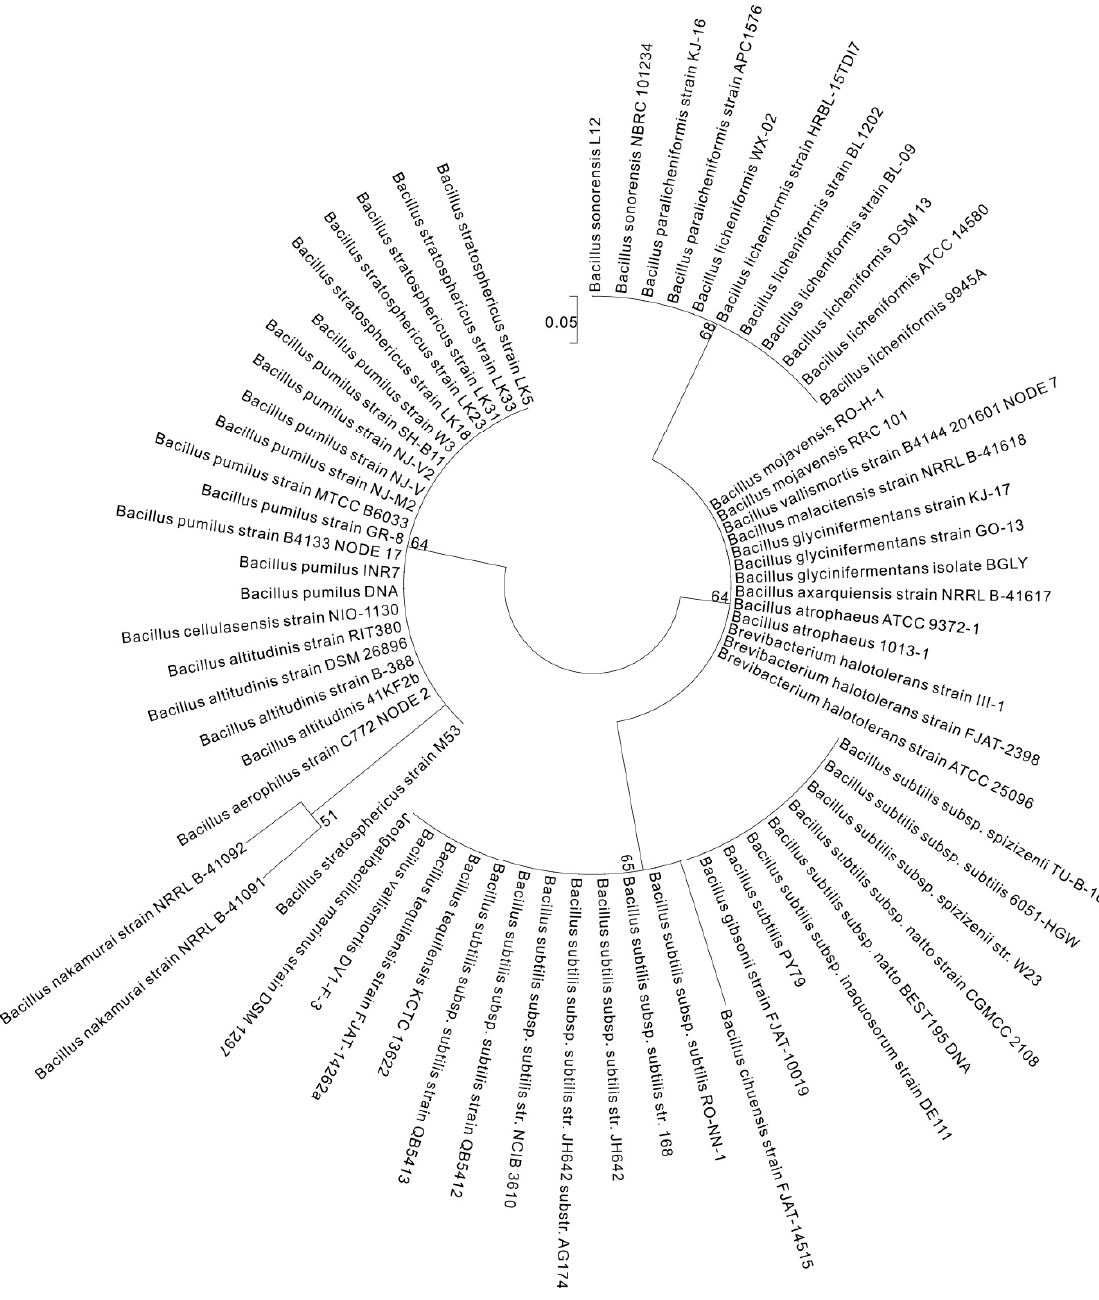
Figure 7. Molecular phylogenetic analysis of pgdS by the maximum likelihood method. The phylogenetic tree with branch lengths was measured as the number of substitutions per site. The analysis involved 192 nucleotide sequences. Partial deletion was used and all positions with less than 95% site coverage were eliminated, i.e., less than 5% of the alignment gaps, instances of missing data, and ambiguous bases were allowed at any position. Scale bar: number of substitutions per site. Evolutionary analyses were conducted in MEGA7 [38].